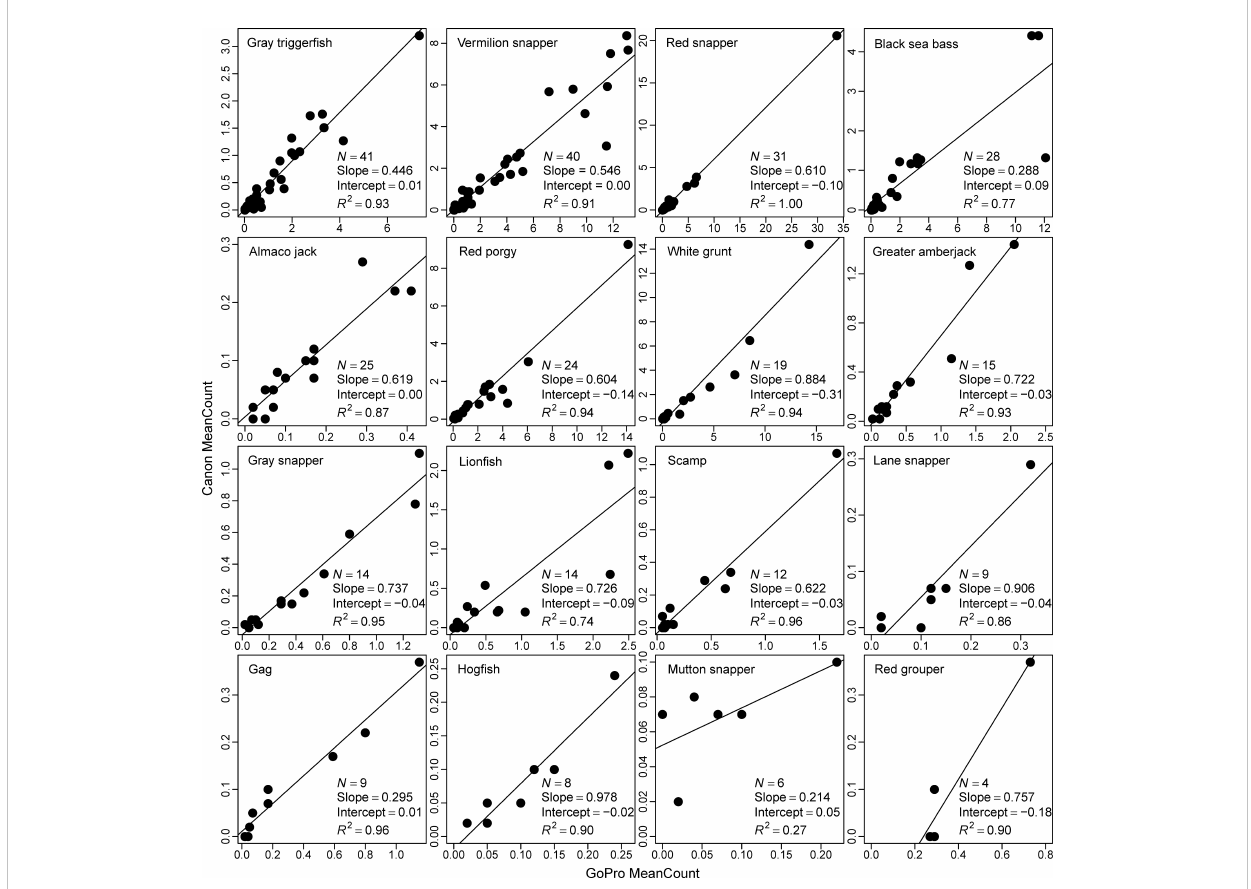
FIGURE 3 Species-speci fi c calibrations of Canon ® Vixia HF-S200 and GoPro Hero 3+ cameras for 16 reef-associated fi sh species along the southeast United States Atlantic coast in 2014. Only species observed on at least 4 videos were included here. Slope, intercept, and the R 2 value were estimated using linear